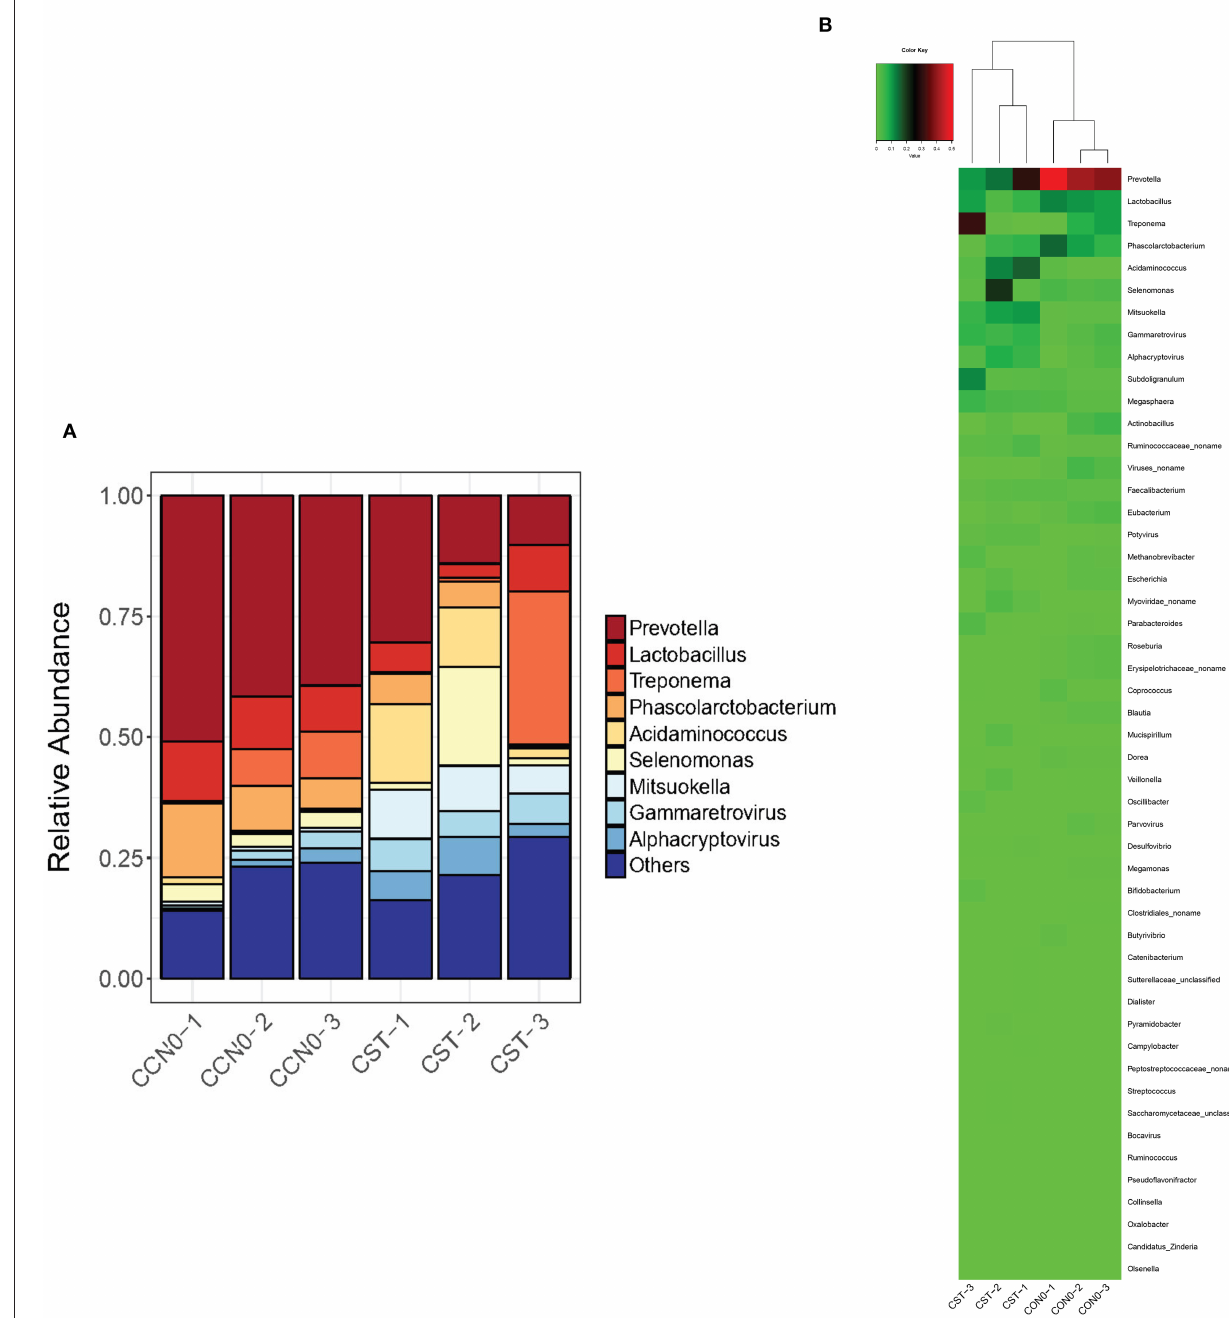
FIGURE 5 | Effects of colistin on microbiome composition changes at the genus level displayed as a bar chart (A) and a heatmap (B) . The abundance of genera is shown on the y axis. Group 1, control group; group 2, colistin group.